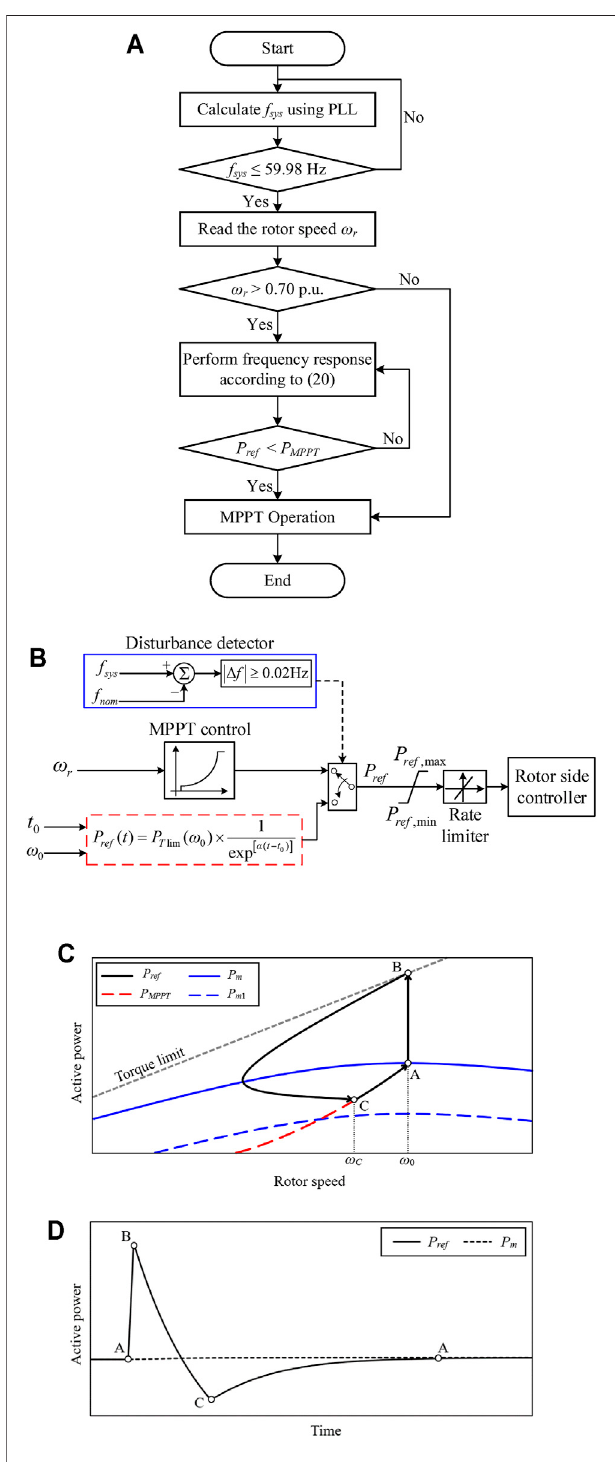
FIGURE 4 | Operational features of the proposed TLBIC scheme: (A) FlowchartoftheproposedTLBICscheme; (B) Blockdiagramoftheproposed TLBIC scheme; (C) Power trajectory in the ω r domain; (D) Active power in the time